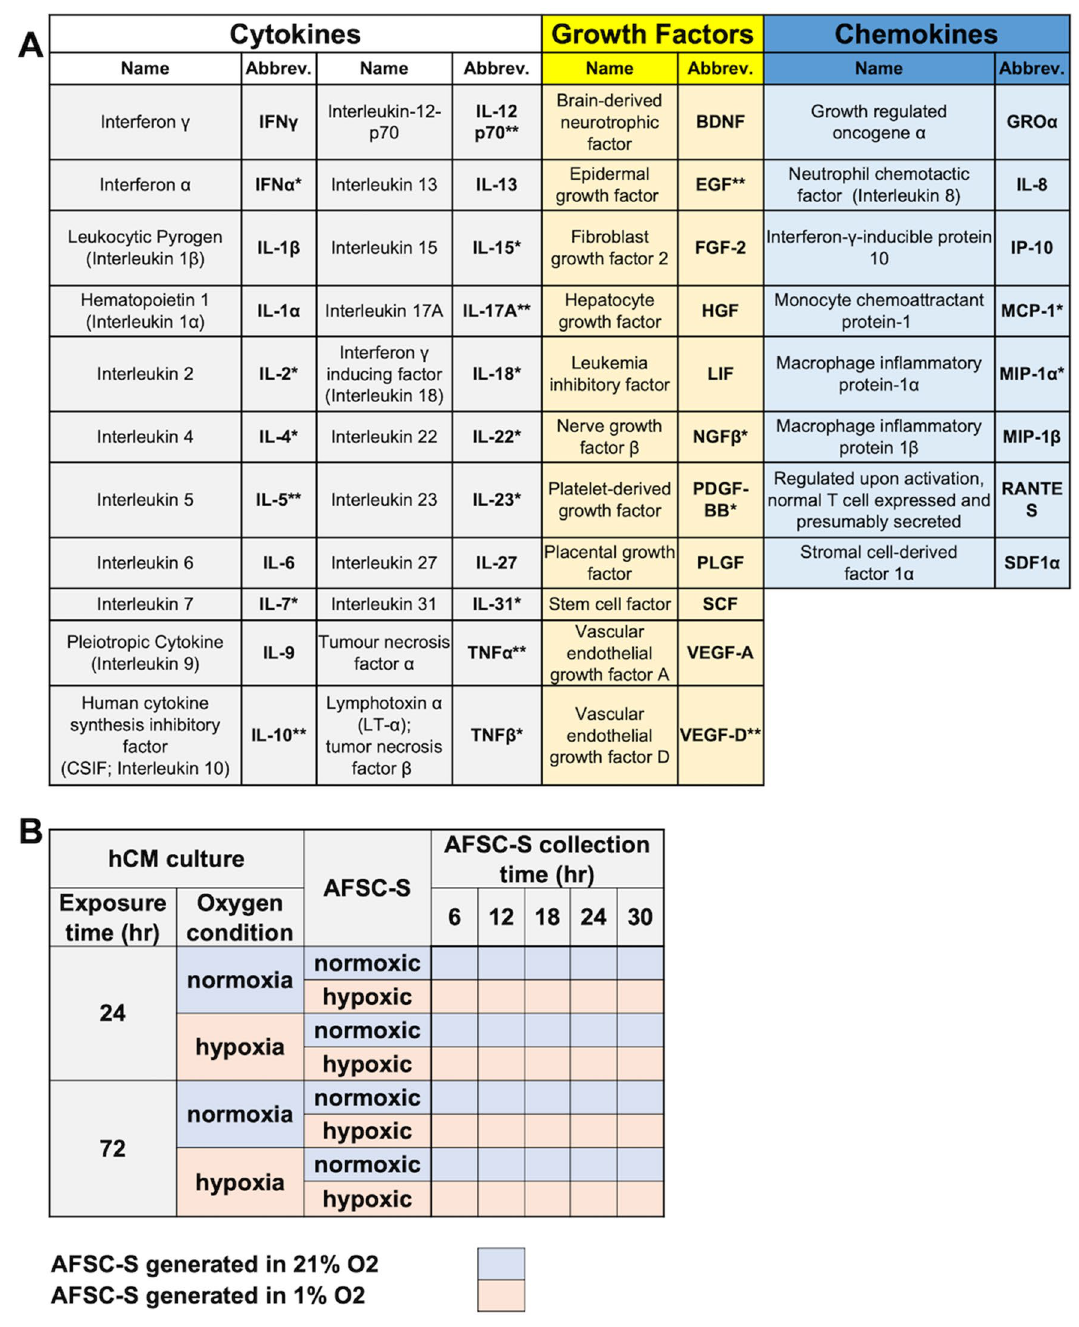
Table 1. List of analytes and secretomes. A) List of all 41 screened analytes. Analytes grouped according to their functions as cytokines, growth factors and chemokines. Not detected analytes—one asterisk, analytes compared only in 12 h-nAFSC-S and 12 h-hASFC-S—two asterisks. B) List of AFSC-S and hCM culture conditions. Respective abbreviations indicated in both